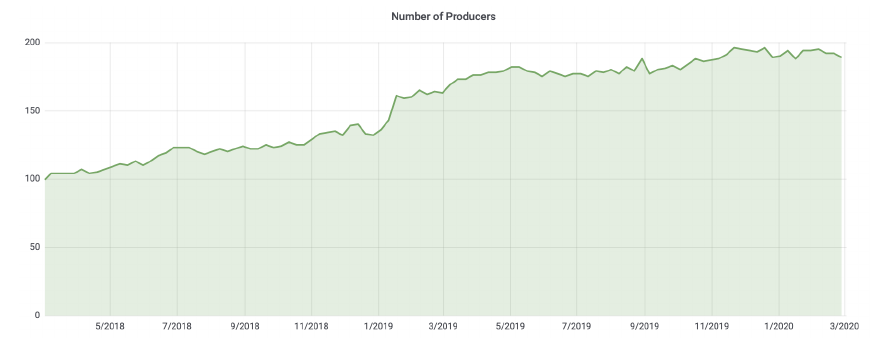
Figure 2: Number of data producers integrated in the MONIT infrastructure